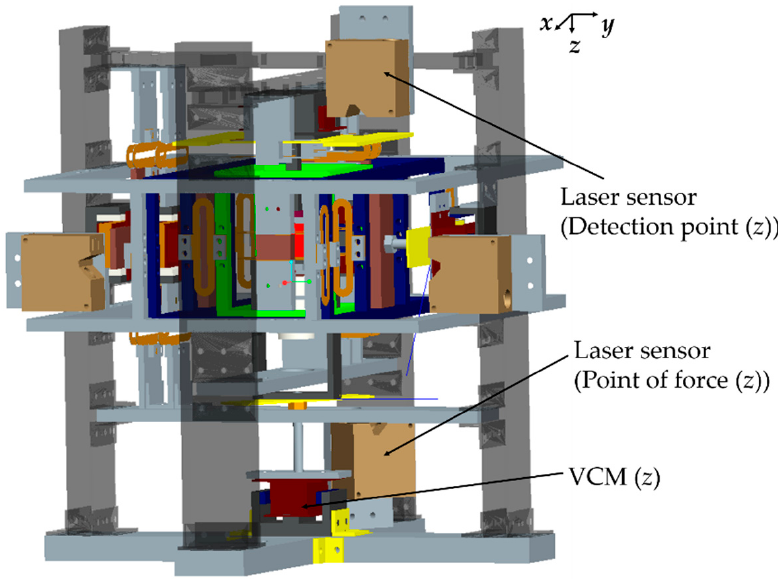
Figure 9. Schematic diagram of the microforce measurement setup.